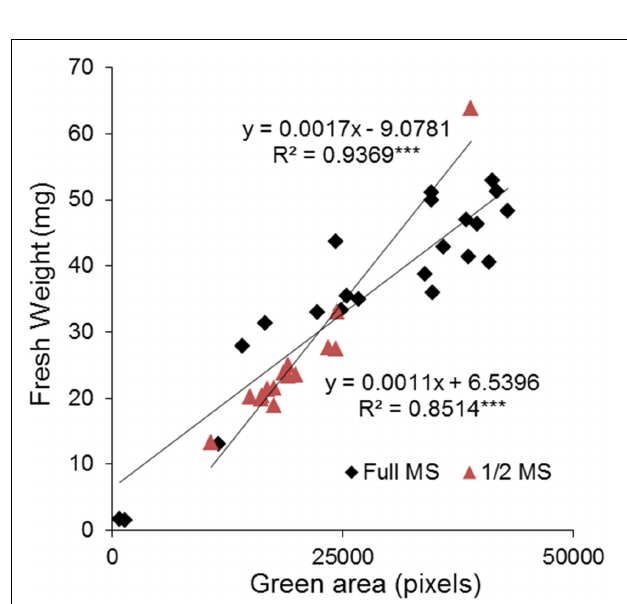
FIGURE 6 | Validation between high-through phenotyping and traditional biometric methods for the analysis of Arabidopsis rosette growth in multi-well plates. Correlation between projected green area (pixels) and fresh weight (mg) of 13 DAG Arabidopsis seedlings grown in 24-well plates with 1 × and 0.5 × MS for 9 days. The equation of the curve and the Pearson’s correlation coefficient with significance according to ANOVA were calculated. ∗∗∗ p <